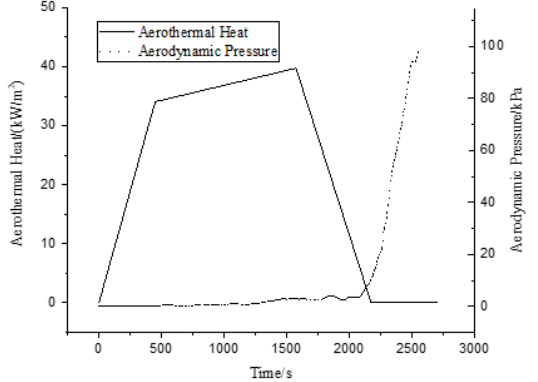
Figure 2. Aerodynamic load during re-entry time [44]. Table 2. Ambient temperatures.